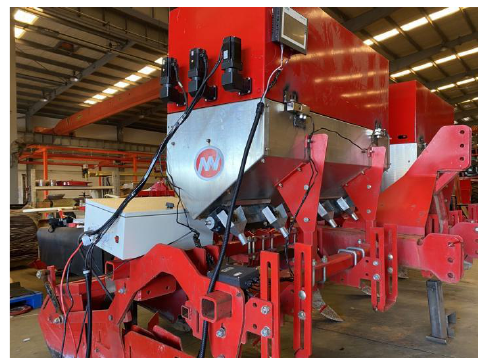
Figure 9. Test prototype. Appl. Sci. 2021 , 11 , x FOR PEER REVIEW